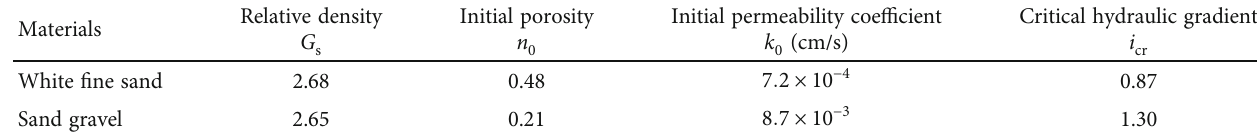
Table 1: Physical and mechanical parameters of materials [23].